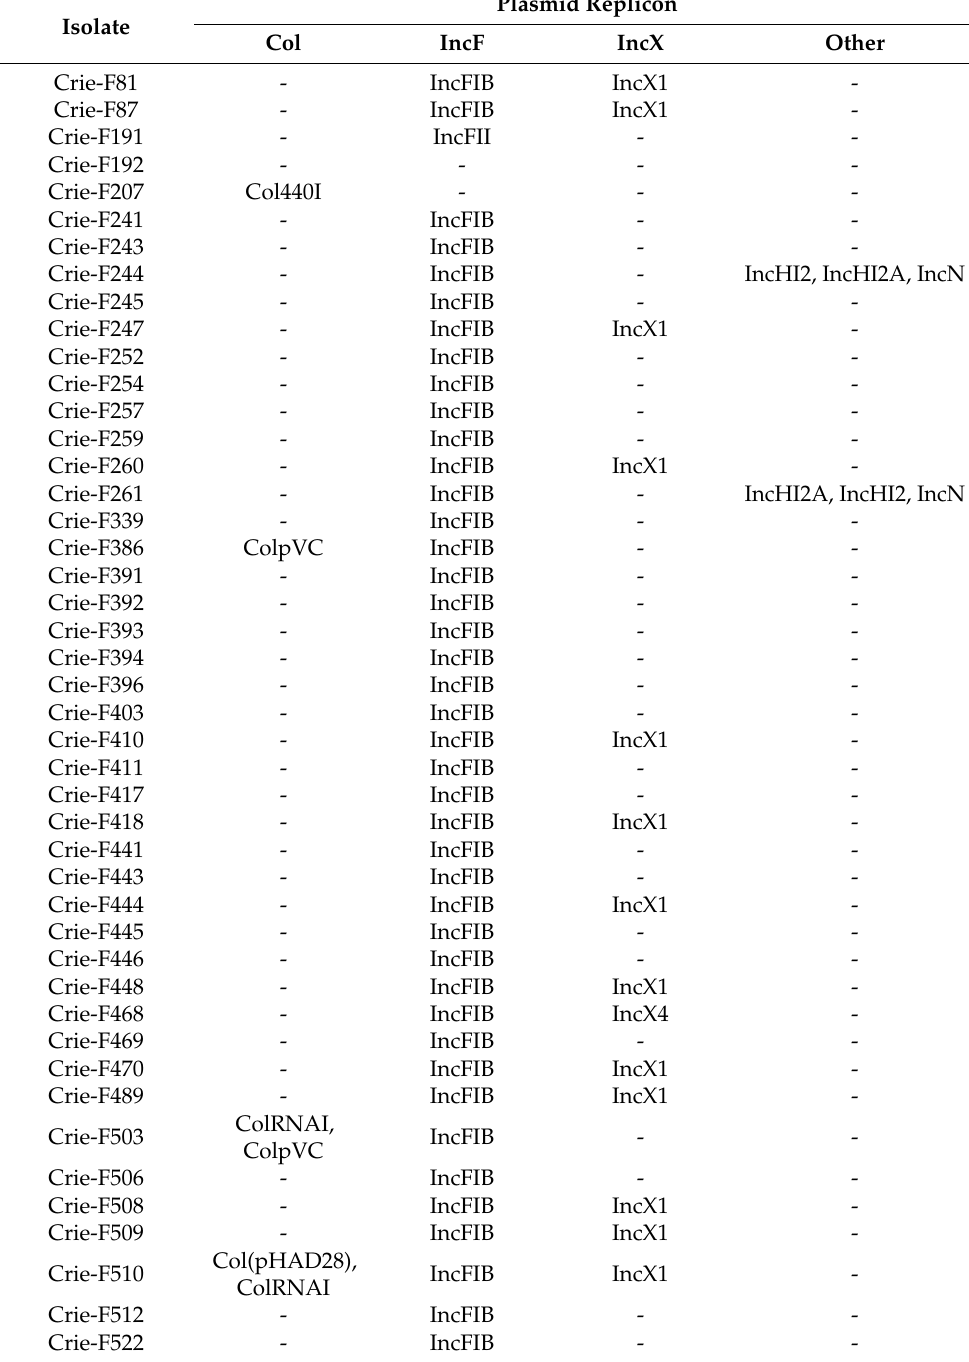
Table 2. Plasmid replicons found in the